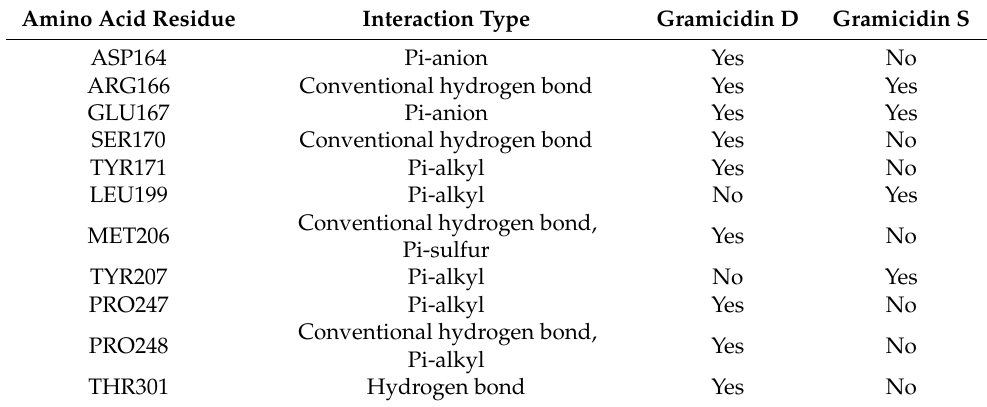
Table 1. Intermolecular interactions between SARS-CoV-2 PL pro and gramicidin D/gramicidin S.